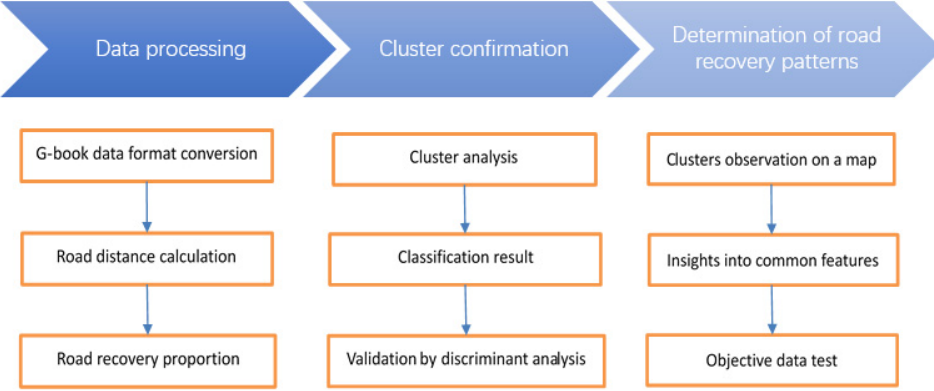
Figure 1. Research flowchart for determining road recovery patterns.